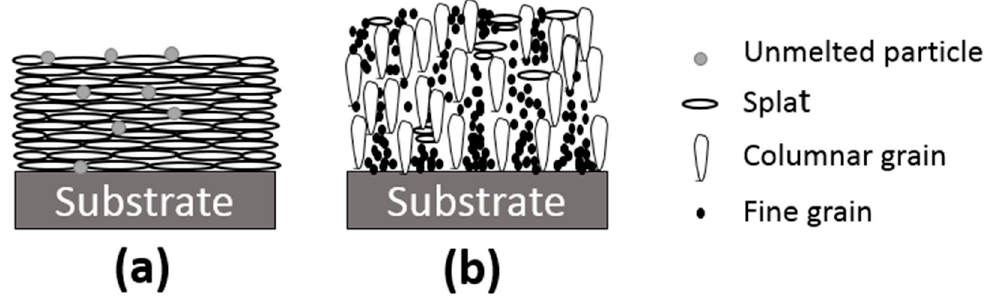
Figure 3. Schematic diagram of deposition mechanism for ( a ) VLPPS coating; ( b ) PS-PVD coating.